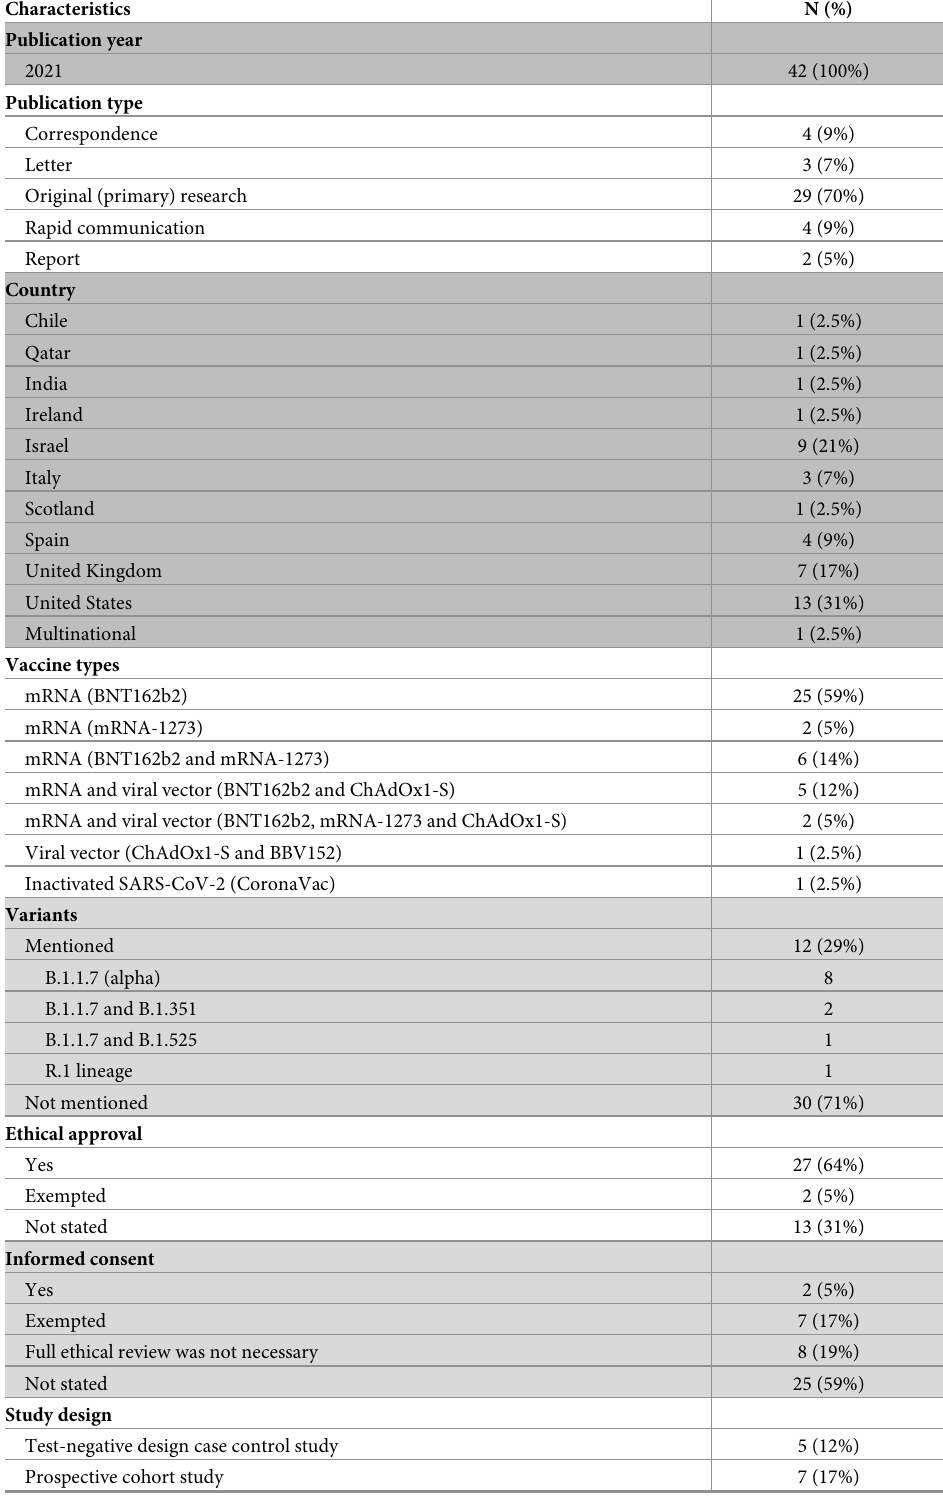
Table 1. General characteristics of articles on real-world effectiveness of COVID-19